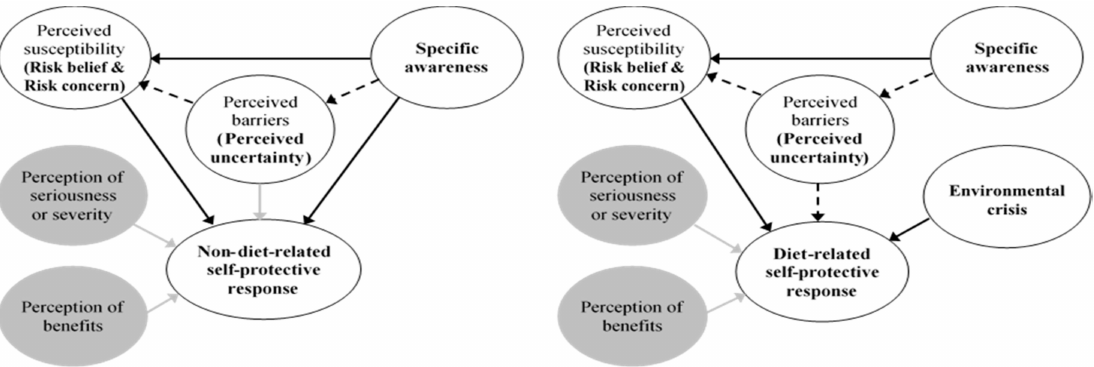
Figure 5. The role of specific awareness and perceived uncertainty in contributing to the HBM [41]. Note: Shaded boxes and gray lines: the constructs and the relationships described in the HBM; unshaded boxes and black lines: the modifications by this study; solid lines: direct effects; dot lines: indirect/moderation